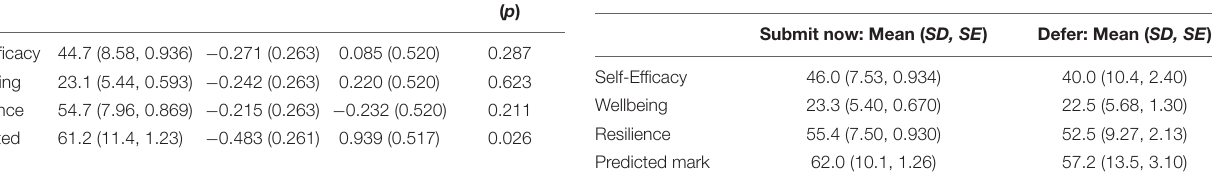
TABLE 2 | Descriptive statistics by group: submitting